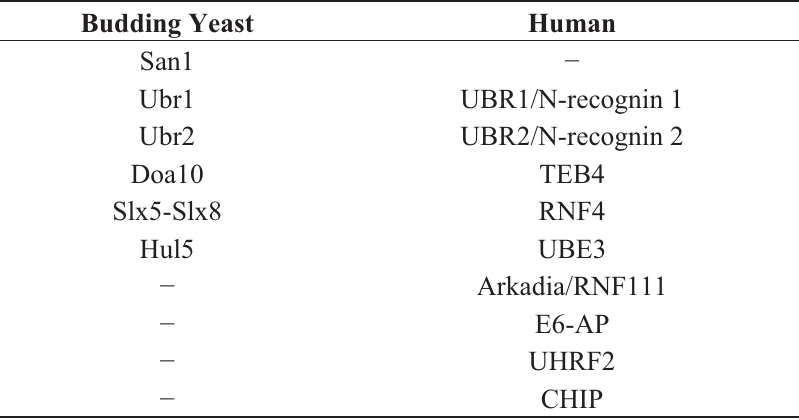
Table 1. E3 ubiquitin-protein ligases in nuclear protein quality